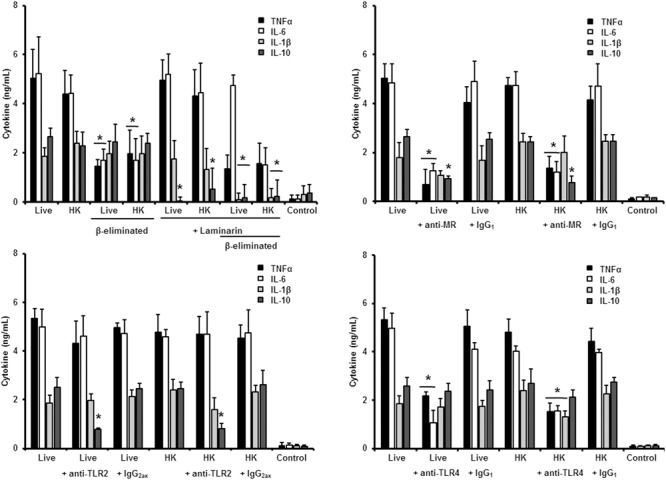
Cytokine production by human PBMCs stimulated with S. schenckii sensu stricto conidia. Human PBMCs were co-incubated 24 h with either live, HK, live and β-eliminated, or HK and β-eliminated conidia, supernatant collected and used to quantify the cytokine levels. Alternatively, human PMBCs were pre-incubated with laminarin, anti-MR, anti-TLR2 or anti-TLR4 antibodies before interaction with fungal cells. Irrelevant, isotype-matching antibodies were used as controls, as indicated. ∗P < 0.05, when compared with untreated cells.